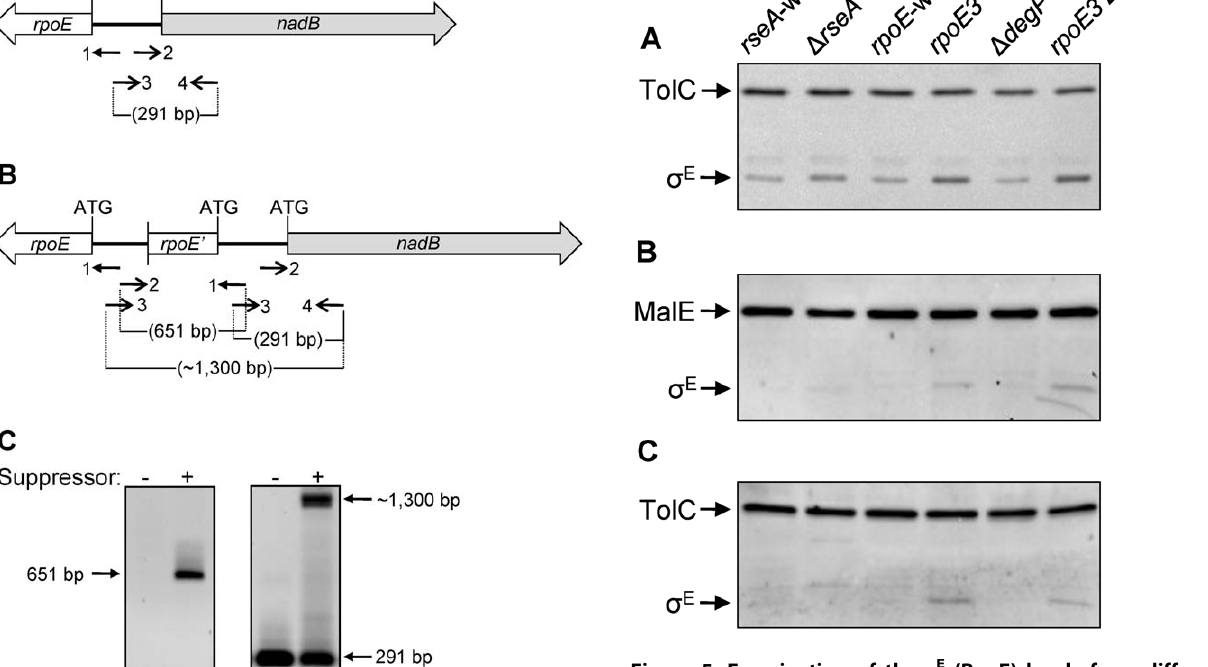
Figure 5. Examination of the s E (RpoE) levels from different genetic backgrounds and cell fractions. s E was detected by Western blots from protein samples obtained from whole cells ( A ), soluble ( B , periplasm and cytoplasm) and insoluble ( C , membranes) fractions. TolC-specific and s E -specific antibodies were used in ( A ), while antibodies raised against s E and a MalE-TolC fusion protein were used in ( B ) and ( C ). The MalE-TolC fusion antibodies were used to verify the purity of soluble (MalE) and insoluble or membrane (TolC) fractions. Relevant genotypes of the strains are shown at the top.